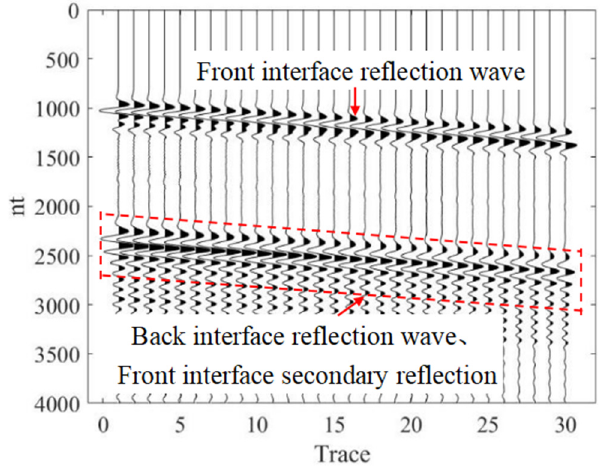
Figure 8. Seismic records of CSP gathers of 30 m thick fault numerical model in underside wall.